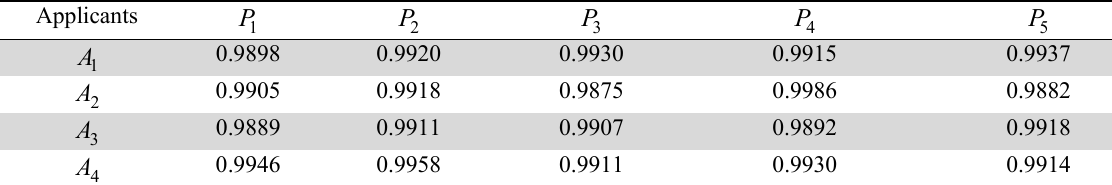
Similarity measure of Applicants vs. Positions using (7) and Type-3 score function